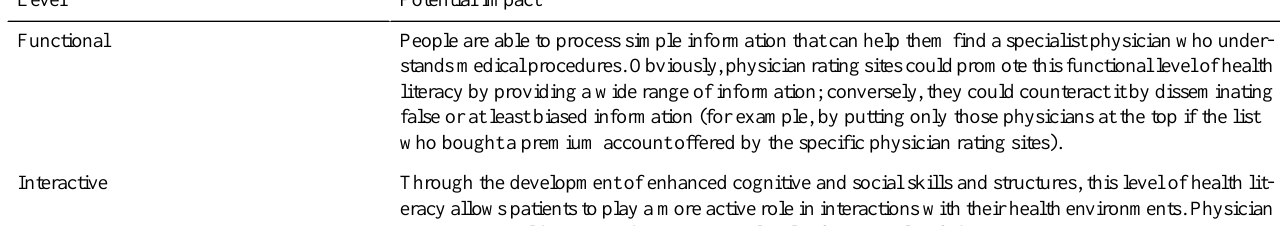
Table 1. The potential impact of physician rating sites on the three levels of health literacy Potential